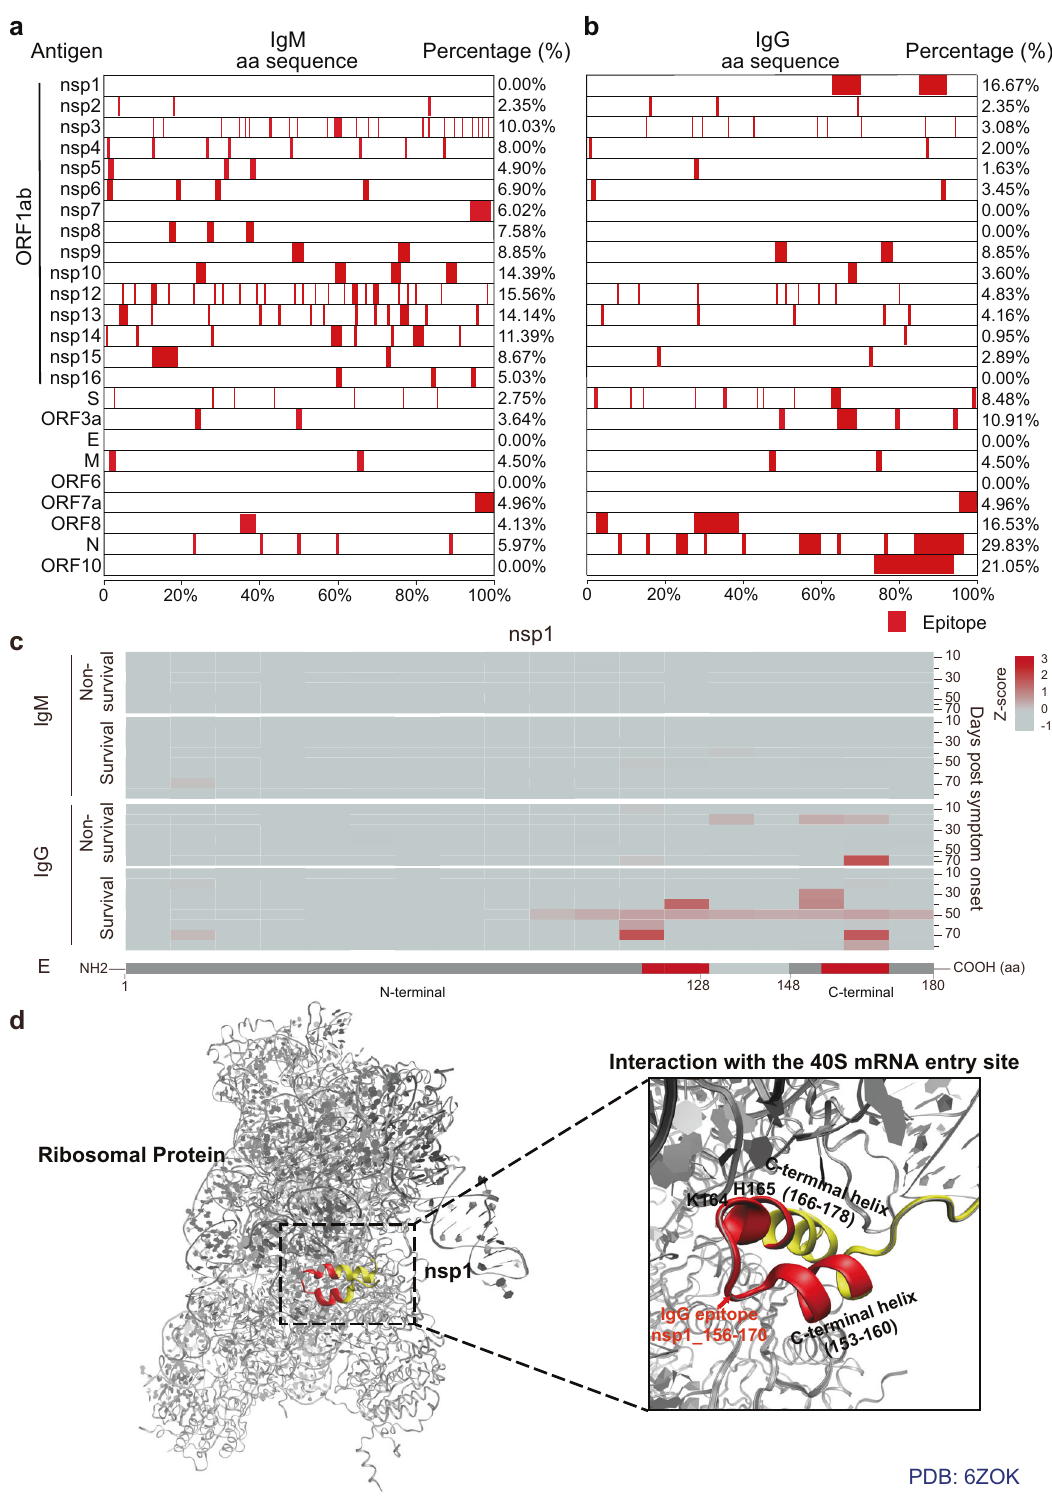
Fig. 3 The landscape of antibody epitopes identi fi ed in critical COVID-19 patients. a , b Landscapes of IgM and IgG antibody epitopes identi fi ed within the SARS-CoV-2 proteome, respectively. The left y -axis is the protein name and the right y-axis is the percent coverage of peptide epitopes on each protein sequence. c Longitudinal changes of IgM and IgG antibody epitopes identi fi ed within the SARS-CoV-2 nsp1 protein. d Structural analyses of IgG antibody epitopes within the SARS-CoV-2 nsp1 protein. The epitopes within the functional domain that may interfere with protein activity are labeled in